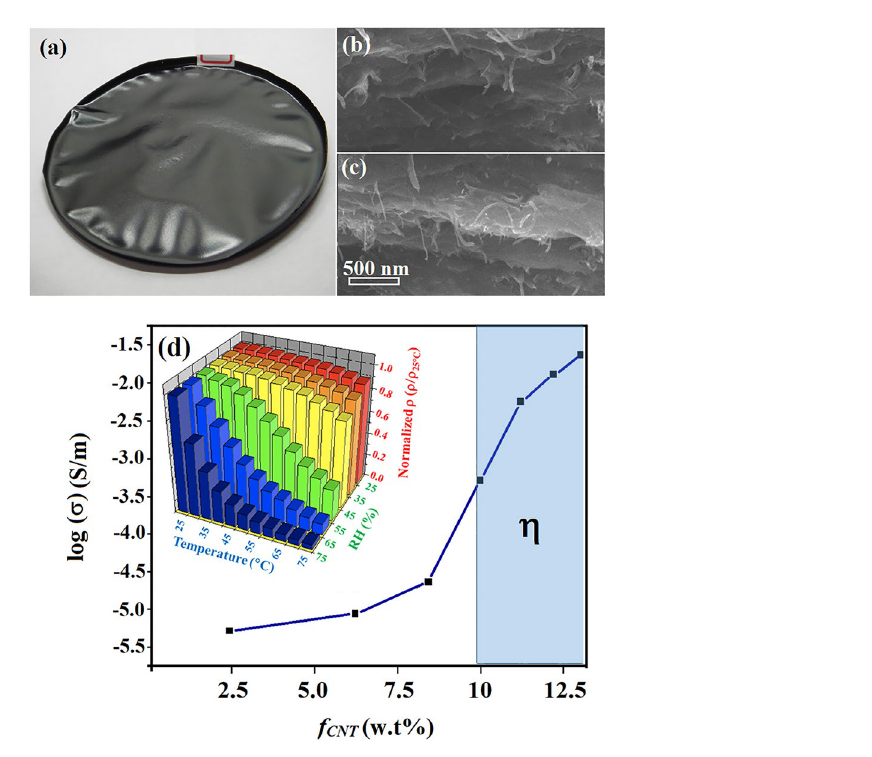
Figure 2. Scheme of DL creation by E application. Suspension consisting of PVA, Fe 2 (SO 4 ) 3 (aq) and CNTs at E = 0 (left) and E > 0 (right).